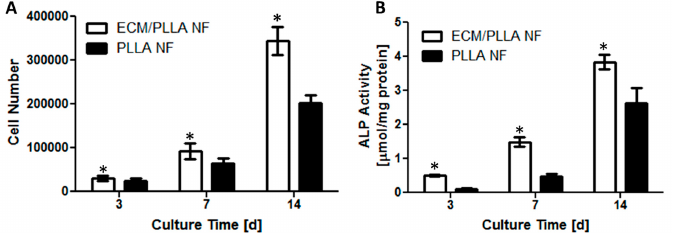
Figure 3. mBMSCs proliferation and osteogenic differentiation on PLLA NF and ECM/PLLA NF for 3, 7 and 14 days: ( A ) The cell number was significantly higher onECM/PLLA NF than on PLLA NF ( p < 0.05) at all time points. ( B ) ALP activity normalized to total protein content of mBMSCs cultured on PLLA NF and ECM/PLLA NF for 3, 7 and 14 days. ALP activities were significantly higher on ECM/PLLA NF than on PLLA NF ( p < 0.05) at all time points. * indicates significant differences.